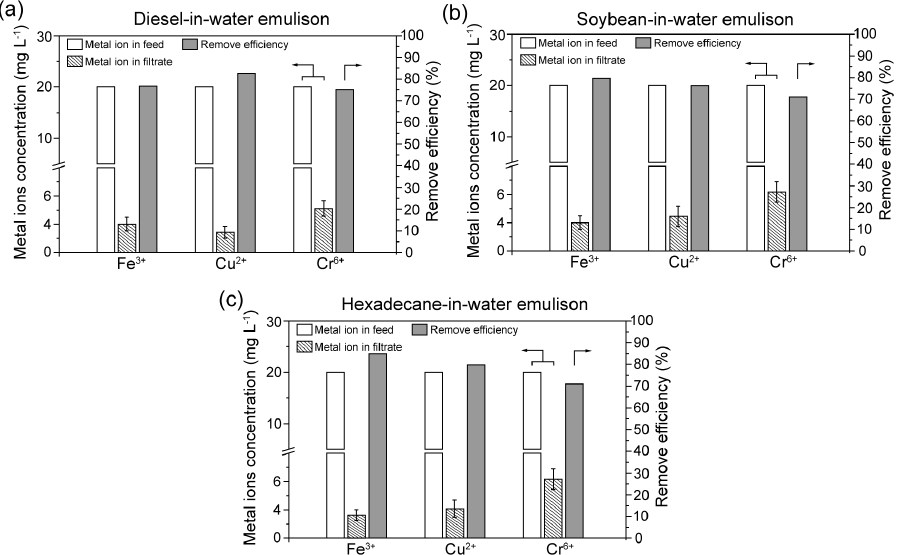
Figure 10. The concentration of heavy metal ions in the feed and filtrate and the corresponding removal efficiency during the separation of ( a ) contaminated diesel-in-water emulsion, ( b ) contaminated soybean oil-in-water emulsion and ( c ) contaminated hexadecane-in-water emulsion.